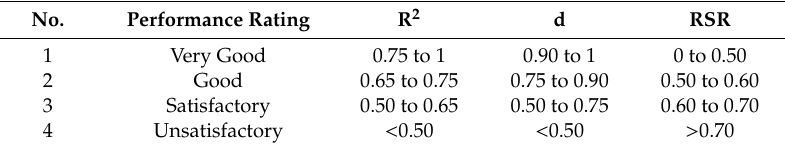
Table 1. General performance ratings for recommended statistics